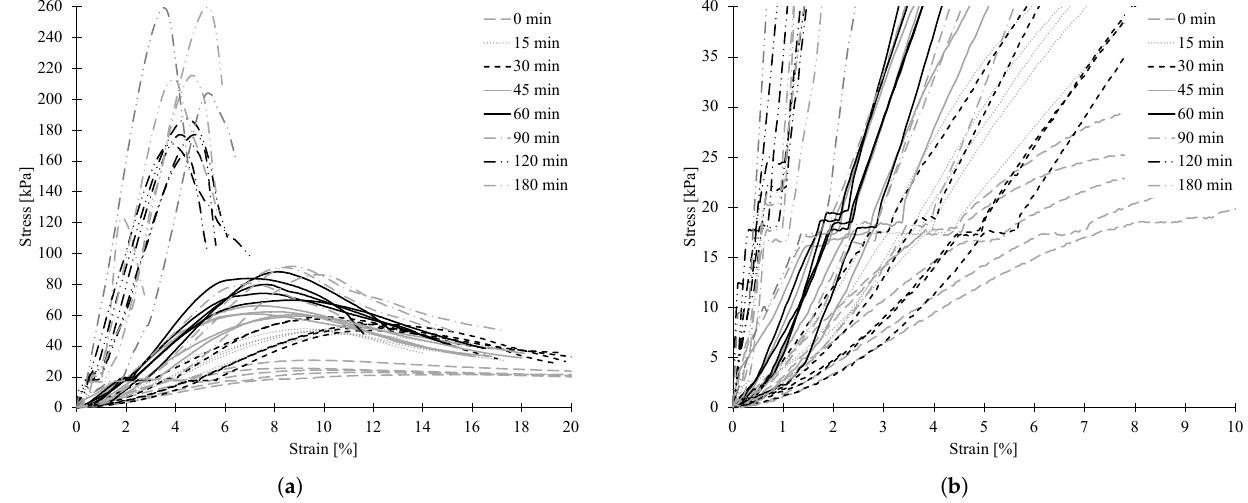
Figure 9. ( a ) Green strength vs. vertical displacement diagrams of the UHPC on fresh state at different resting times, and ( b ) cracks